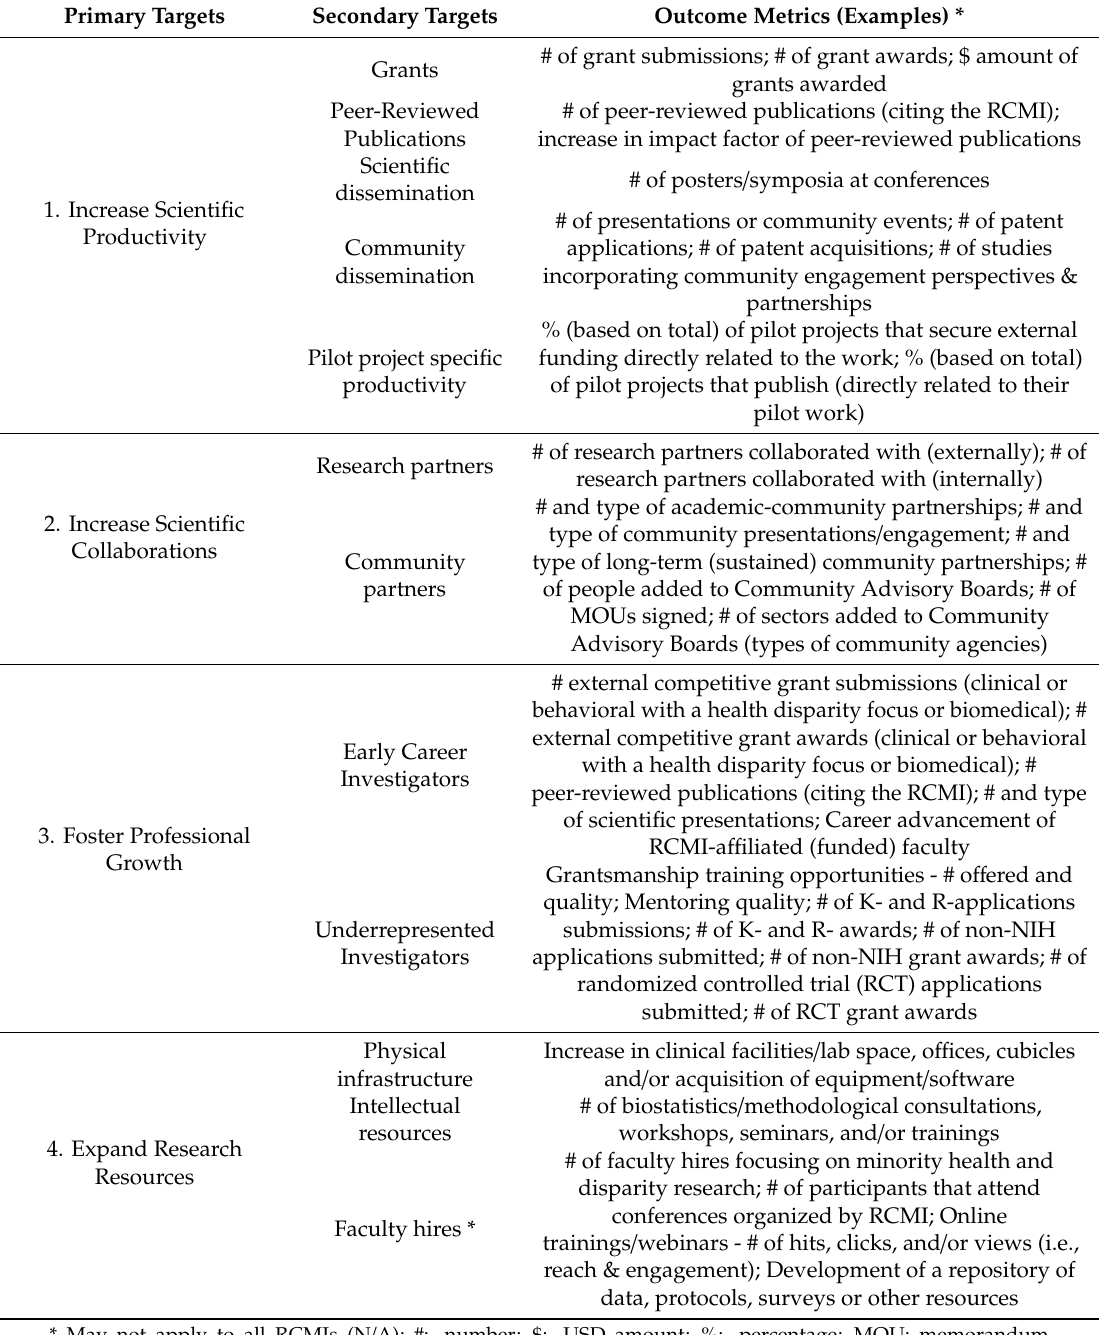
Table 1. Summary of the key RCMI targets and relevant evaluation metrics identified in this